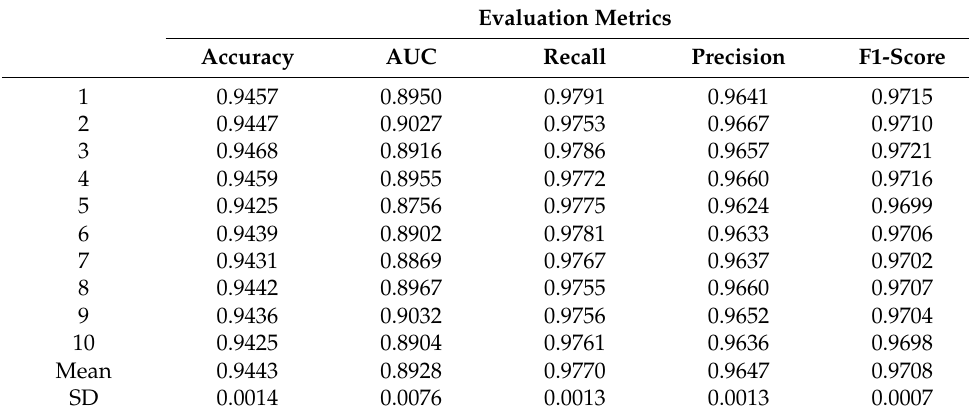
Table 4. The 10-fold cross-validation results for RandomForest.